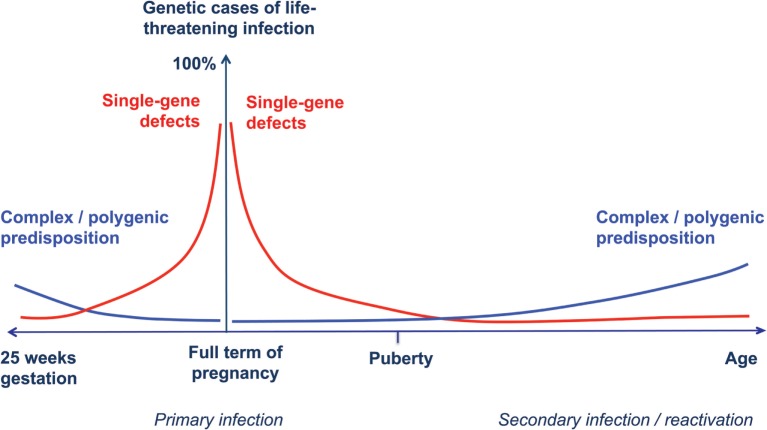
Human genetic architecture of infections. Modified from Alcais et al. (61). The contribution of Mendelian genetic defects (red lines) to life-threatening infectious diseases is mostly observed during childhood, while complex interactions between environmental influences and polygenic susceptibility (blue lines) play a more important role for infections occurring later in life. We propose a specular trend for the contribution of human genetic variants to infection susceptibility with decreasing gestational age. In newborn infants at extremely low gestational ages, exogenous factors play a major role, while host genetic defects are more likely to explain life-threatening infection in full-term, otherwise healthy babies.